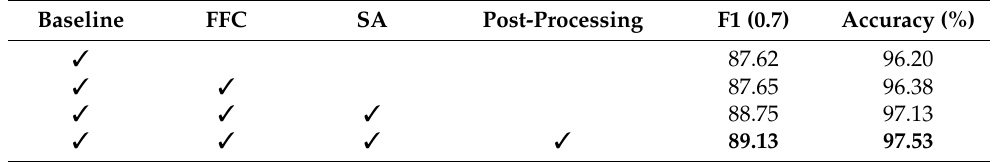
Table 2. Effectiveness of the proposed module.